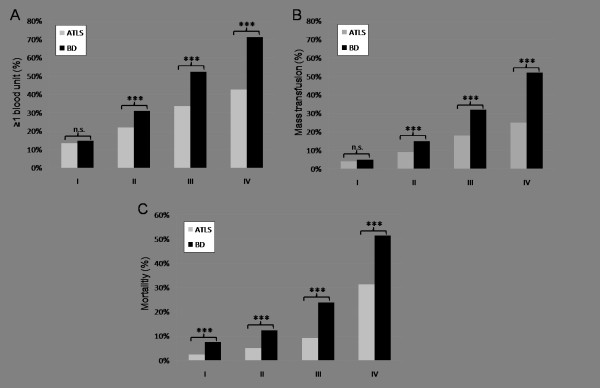
Transfusion requirements and mortality in patients classified according to either admission base deficit (BD) or the ATLS classification of hypovolemic shock. (a) Percentage of patients with at least one blood product. (b) Percentage of patients with massive transfusion, defined as at least 10 blood units until intensive care unit (ICU) admission. (c) Mortality (percentage). ***P < 0.001; n = 16,305. ATLS, Advanced Trauma Life Support; n.s., not significant.